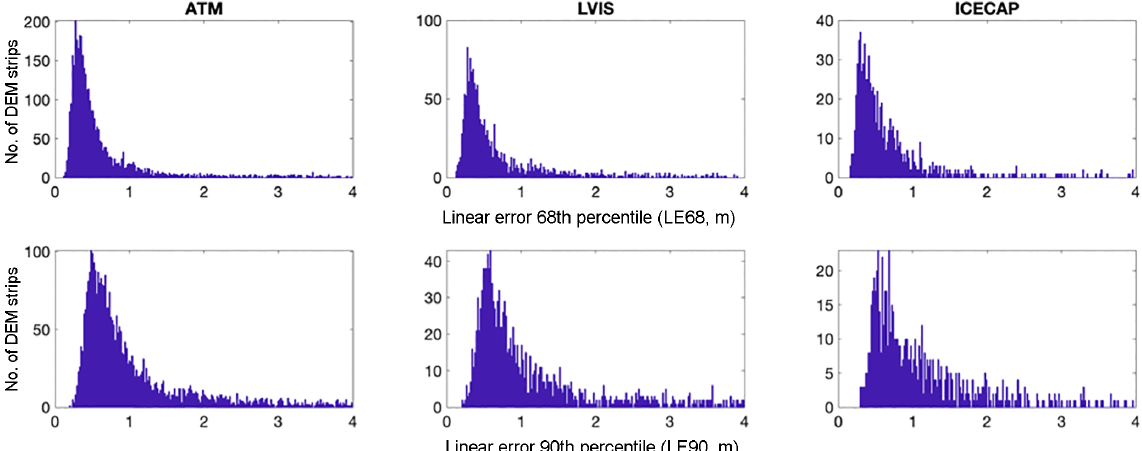
Figure 5. Validation results for DEM strips. Histograms of the 68th and 90th percentiles of the absolute value of vertical residuals, or linear error, among each of three Operation IceBridge lidar systems and REMA DEM strips after